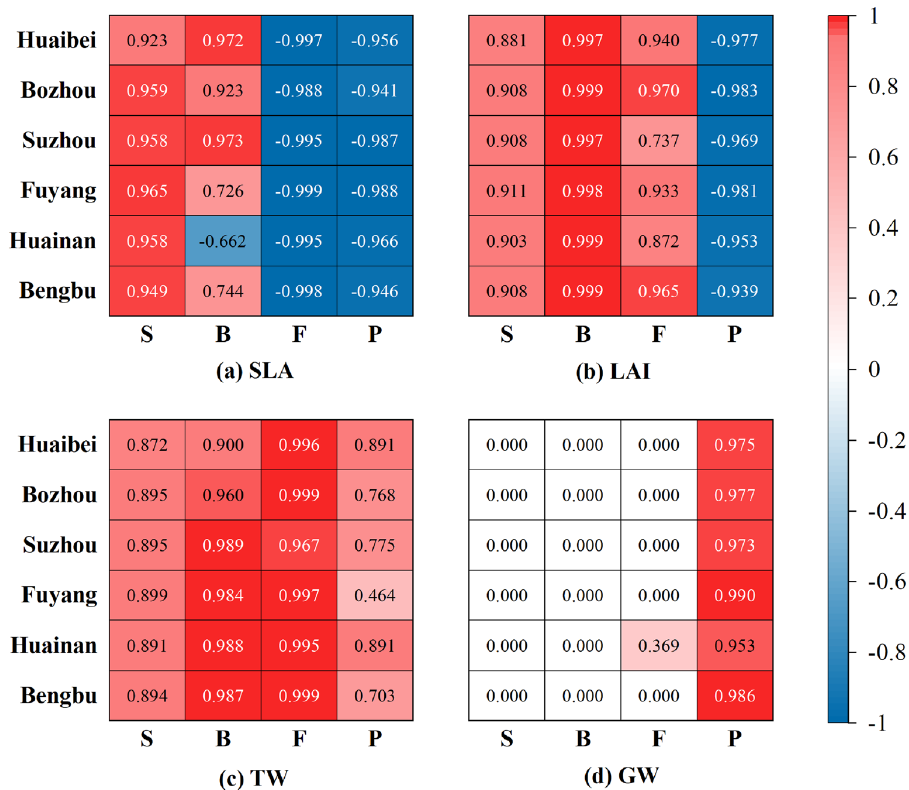
Fig. 5 Correlation matrix of specific leaf area (SLA), leaf area index (LAI), tops weight (TW), and grain weight (GW) in individual soybean growth stages in the Huaibei Plain study area in Anhui Province, China. Note: S = Seedling stage; B = Branching stage; F = Flowering & pod-setting stage; P = Pod-filling